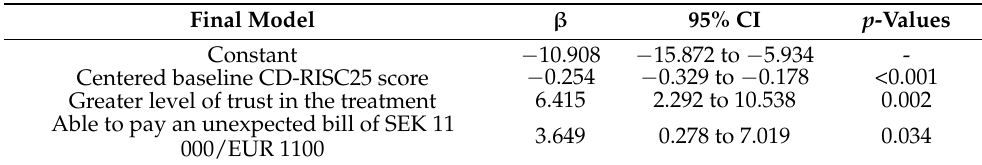
Table 4. Multiple linear regression analyses with stepwise backward elimination A . Predictors of the change in psychological resilience score (score at 1 year post diagnosis minus score at diagnosis) after adjustment for baseline resilience